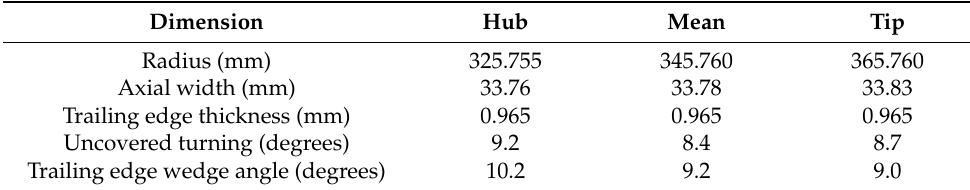
Table 1. Stator vane geometry as described by Timko.